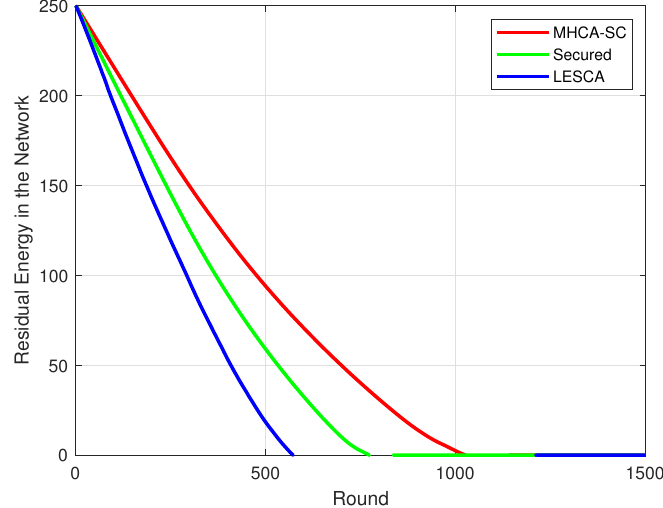
Figure 11. Residual energy: LESCA vs. SMHCA-CS vs. MHCA-CS (500